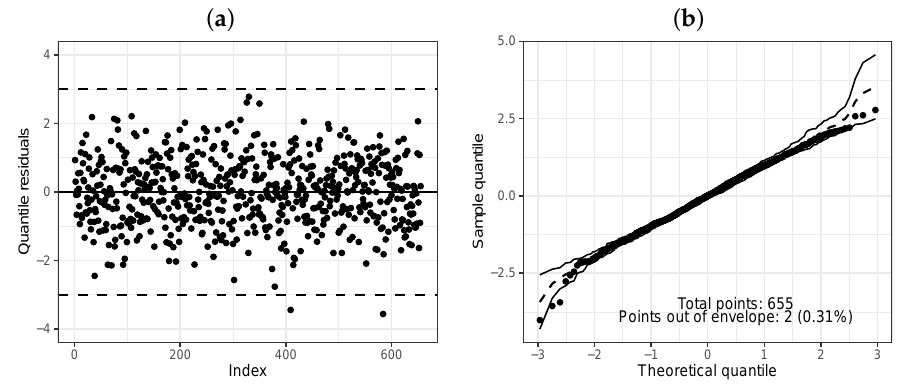
Figure 11. Plots of the qrs for COVID-19 data in Campinas. ( a ) Index plot; ( b ) QQ plot with envelope. Some interpretations of the final WBP regression